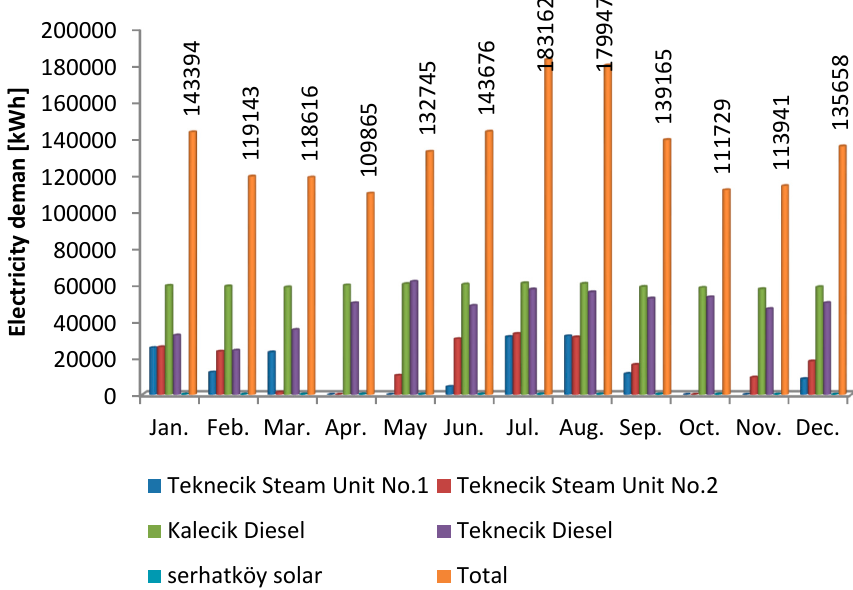
Figure 1. Histogram of monthly electricity demand in Northern Cyprus for the year of 2018 [11].